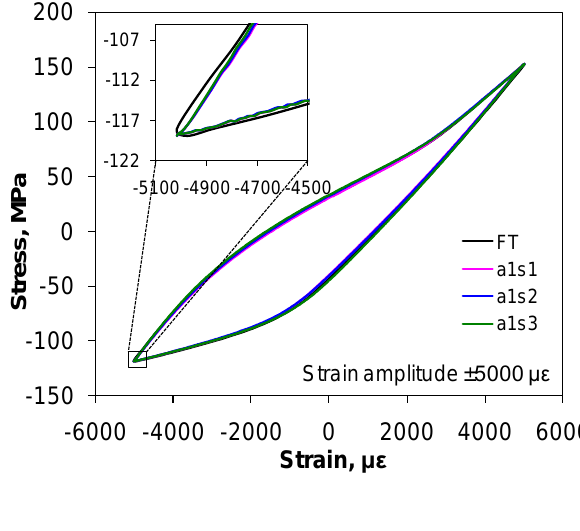
Figure 6. Hysteresis loops of the AZ31 magnesium alloy at the 10th cycle at a strain amplitude of ±5,000 με. The insert shows the enlarged compression-decompression